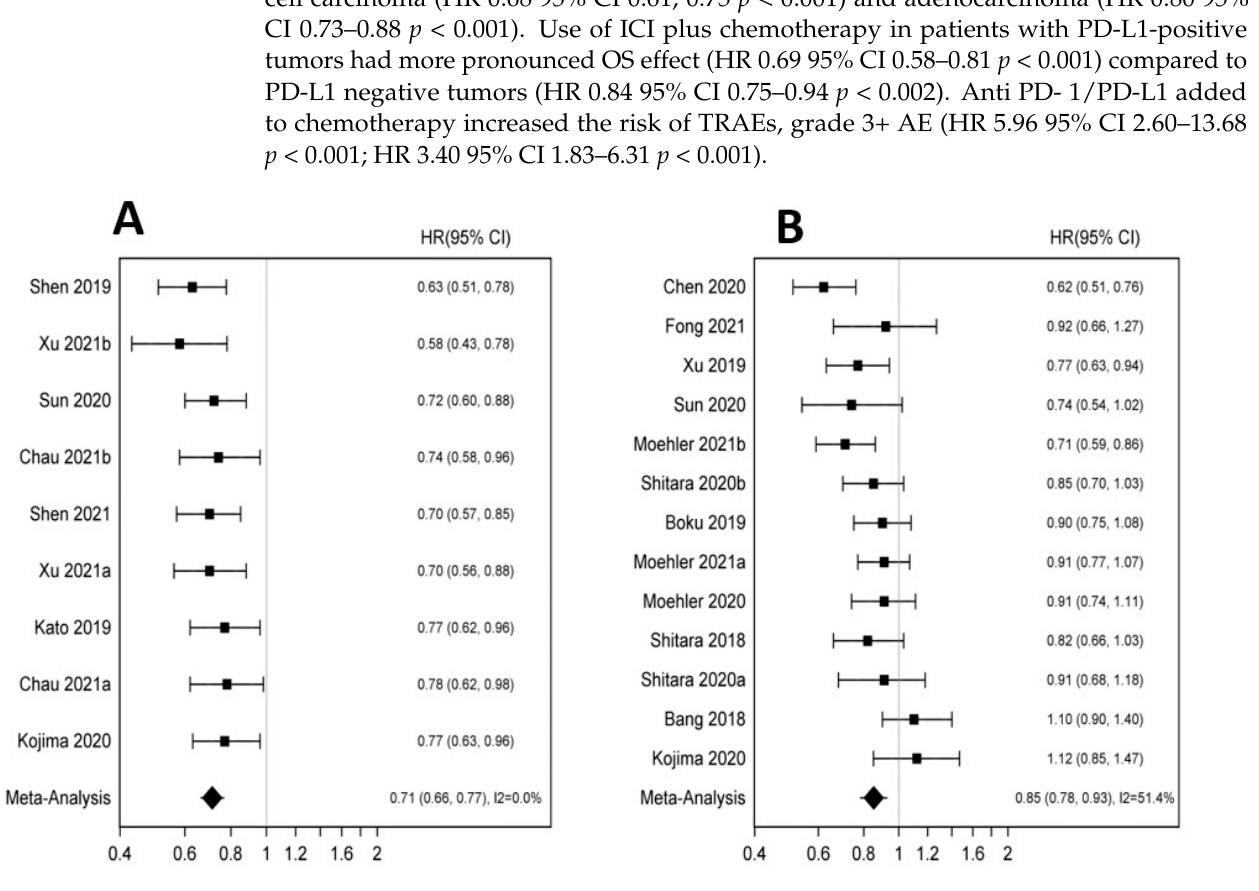
Figure 4. ( A ): Forest plot for overall survival in immunotherapy plus chemotherapy vs. chemotherapy. ( B ): Forest plot for progression free survival immunotherapy plus chemotherapy vs. chemotherapy [5,6,13–17,19,22].